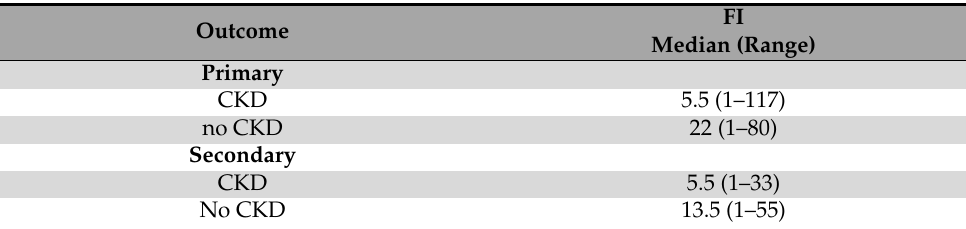
Figure 2. Frequency of fragility index values. Panels ( A , B ) show the absolute frequency of fragility index values for primary and secondary outcomes, respectively. Table 2. Median of fragility index for primary and secondary outcomes with p value lower than 0.05 stratified by CKD and no CKD condition.